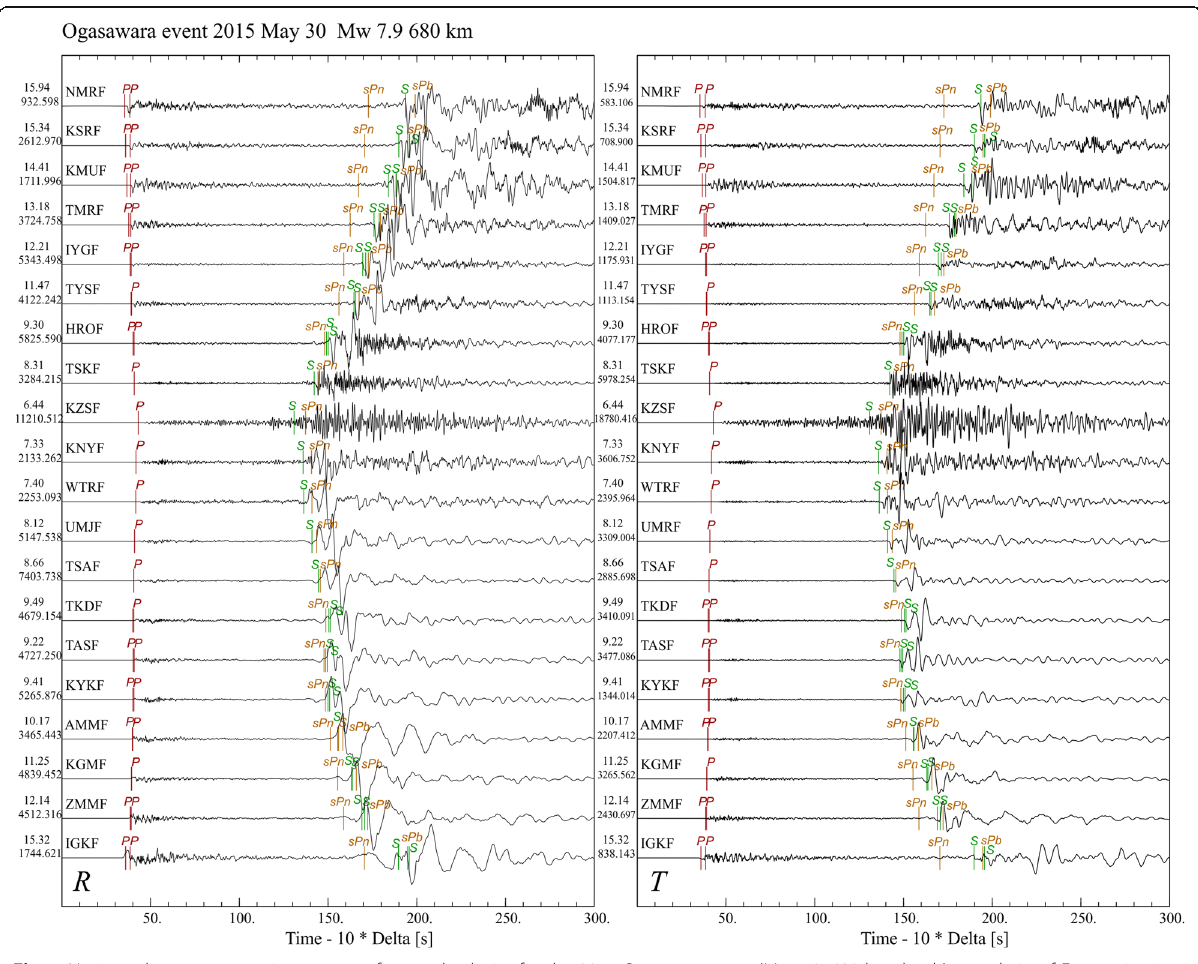
Fig. 7 Horizontal component seismograms of ground velocity for the 2015 Ogaswara event (Mw 7.9, 680 km depth) at a chain of F-net seismic stations along the Japanese islands, shown with solid symbols in Fig. 5. Traces are normalized by the maximum three-component energy in the time